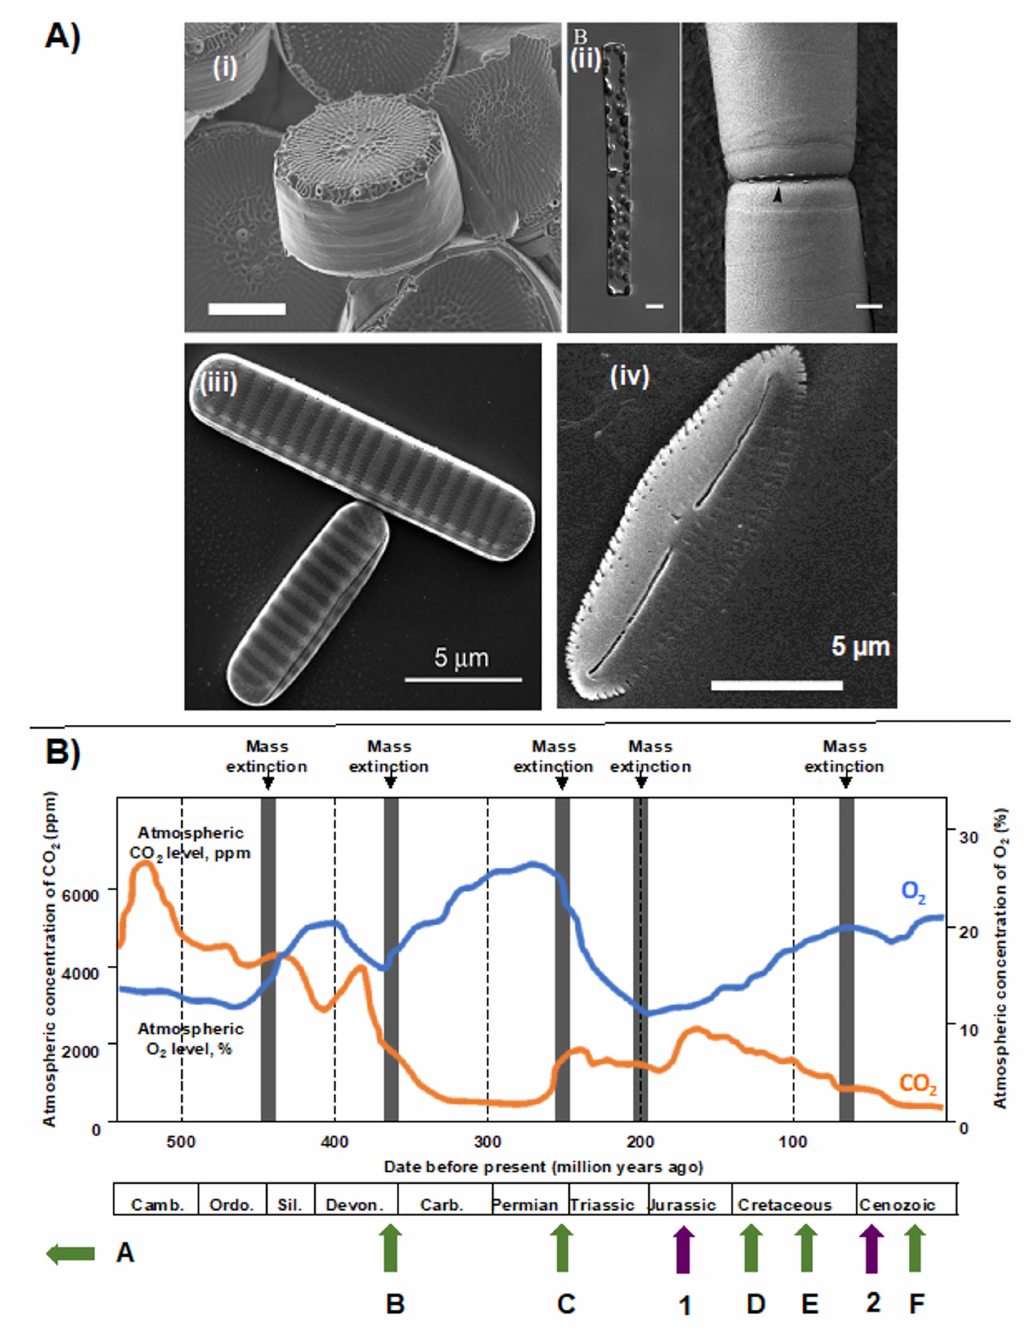
Figure 1. Diatom diversity and origins. Panel ( A ) shows scanning electron micrograph images of ( i ) Thalassiosira pseudonana (polar centric diatom, scale bar: 2 µ m; [30]); ( ii ) Leptocylindrus hargravesii (radial centric diatom, scale bar: 5 µ m); ( iii ) Fragilariopsis cylindrus (raphid pennate diatom, [31]); ( iv ) Fistulifera solaris JPCC DA0580 (raphid pennate diatom, authors’ own image). Panel ( B ) shows a global timeline of atmospheric CO 2 (orange) and O 2 concentrations (blue), adapted from [32], with key events in